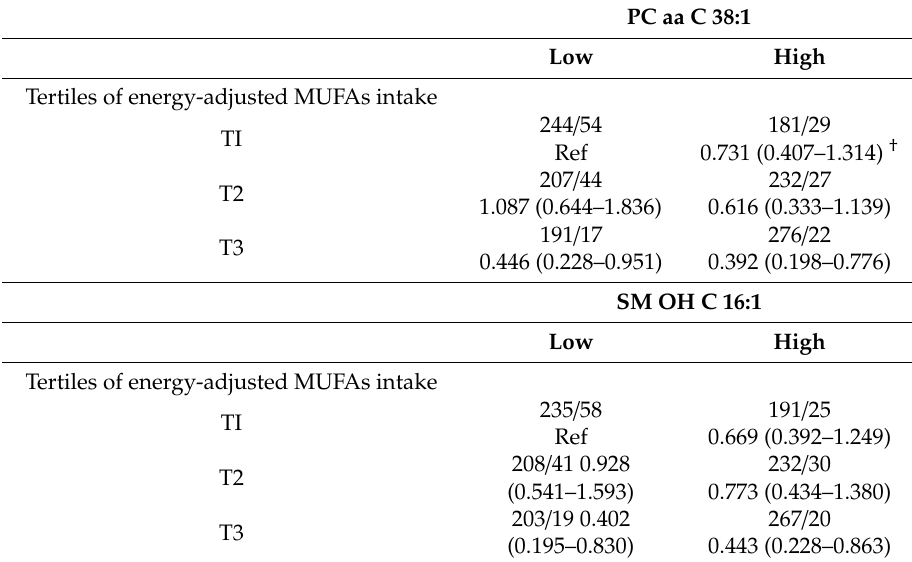
Table 6. Association (OR and 95% CI) between hypertension risk and metabolites combined with dietary MUFAs